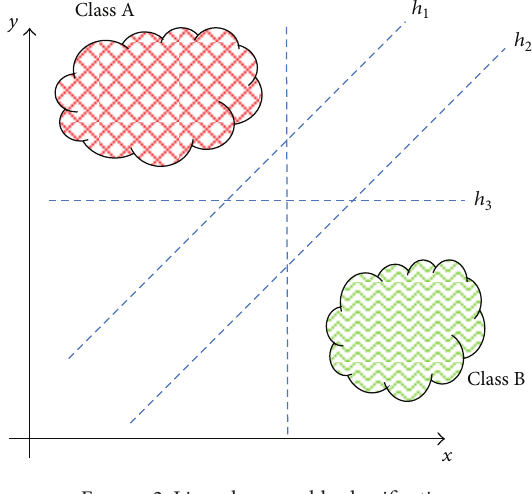
Figure 2: Linearly separable classification.